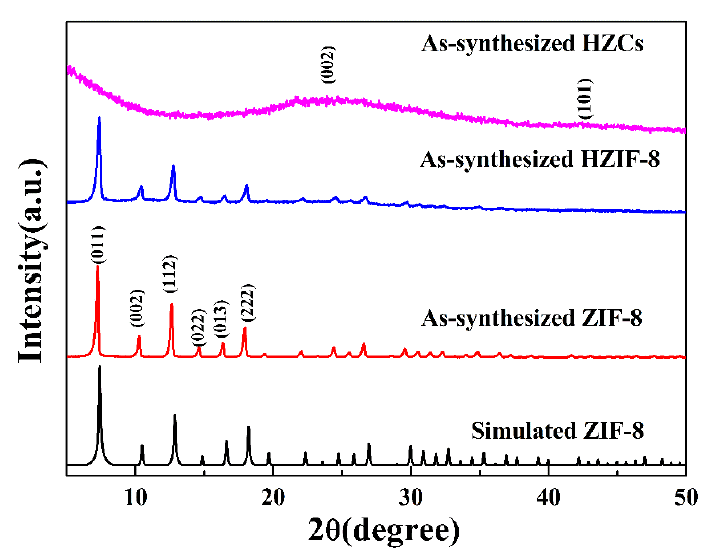
Membranes 2022 , 12 , x FOR PEER REVIEW Figure 3. XRD pattern of ZIF-8, HZIF-8 and HZCs. Figure 3. XRD pattern of ZIF-8, HZIF-8 and HZCs.